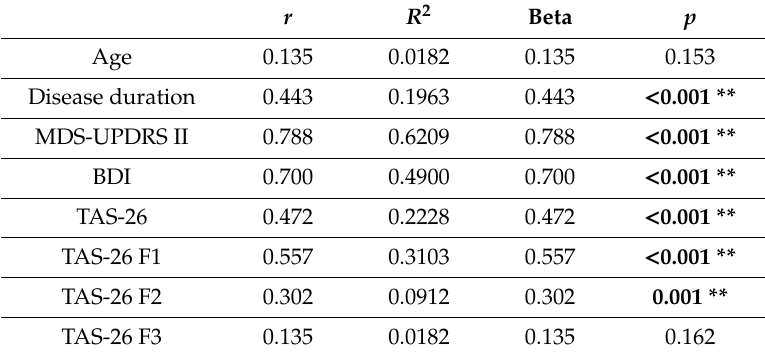
Table 3. Linear regression analysis of factors influencing PD patients’ quality of life measured by the disease specific assessment tool PDQ-8 ( n = 119). r R